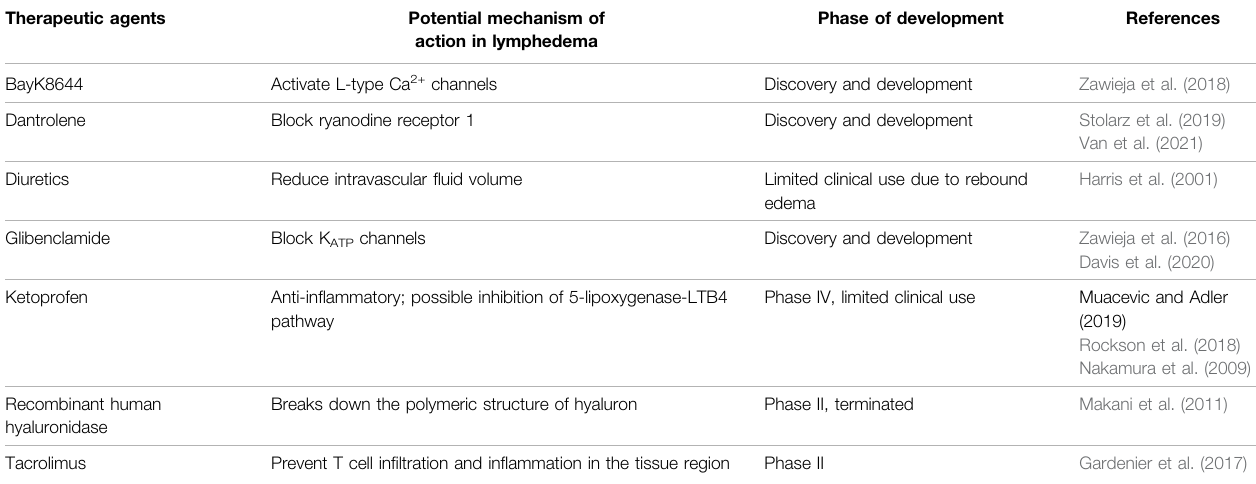
TABLE 2 | Stage of development for potential therapeutic agents for